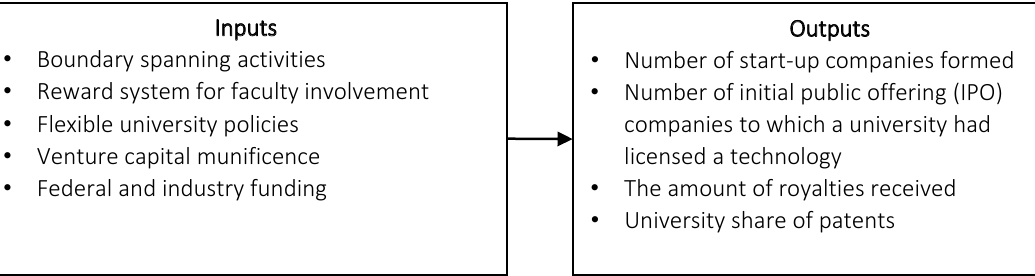
Figure 8. Commercialization efficiency indicators at the university level